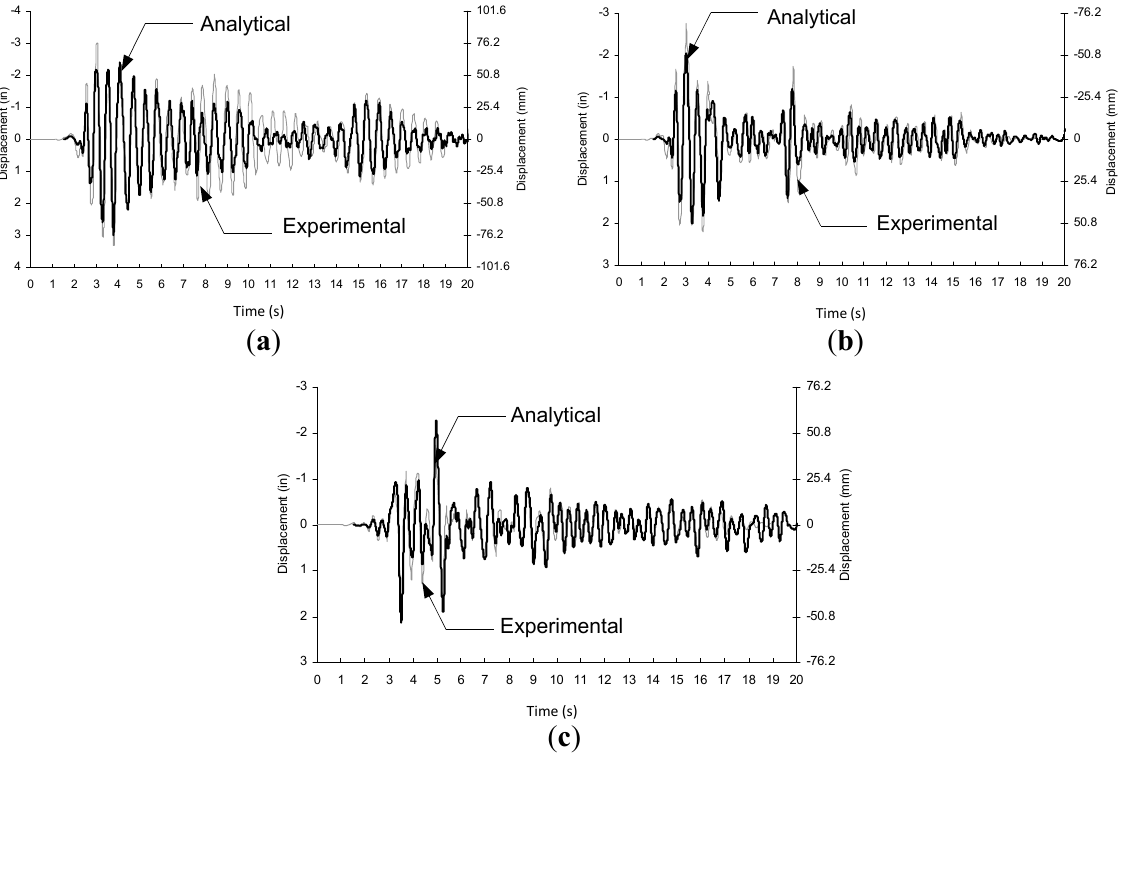
Figure 5. Roof time-histories for OMF and FD. ( a ) OMF Under El Centro; ( b ) FD Under El Centro; ( c ) FD Under